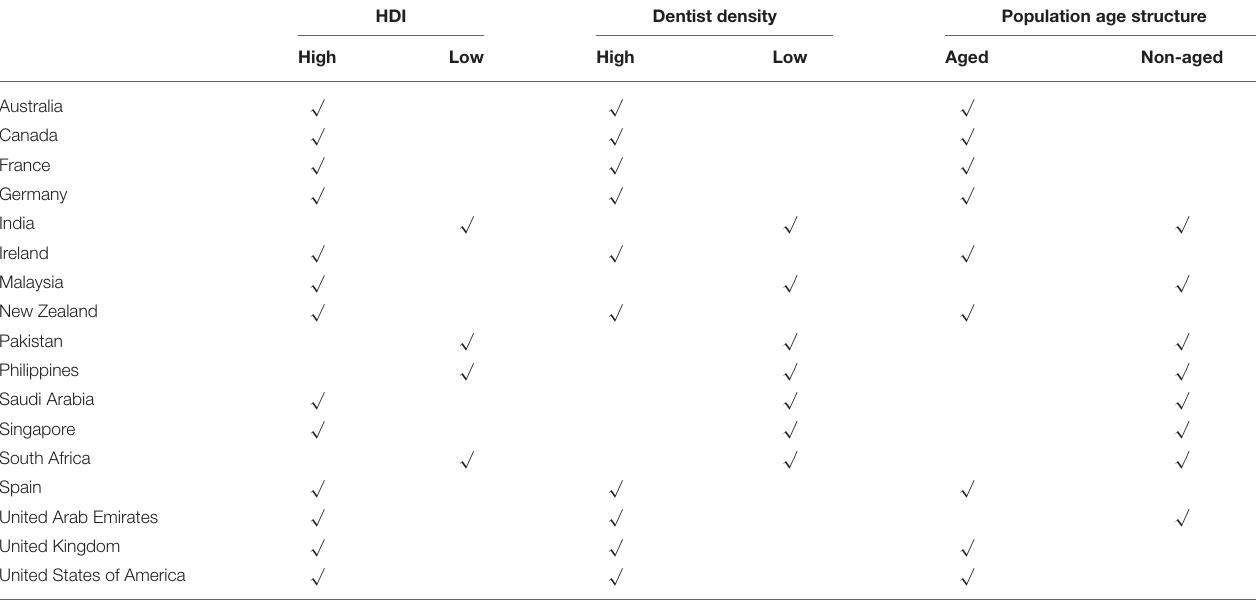
TABLE 2 | Country categories in HDI, dentist density, and population age structure. HDI Dentist density Population age structure High Low High Low Aged Non-aged